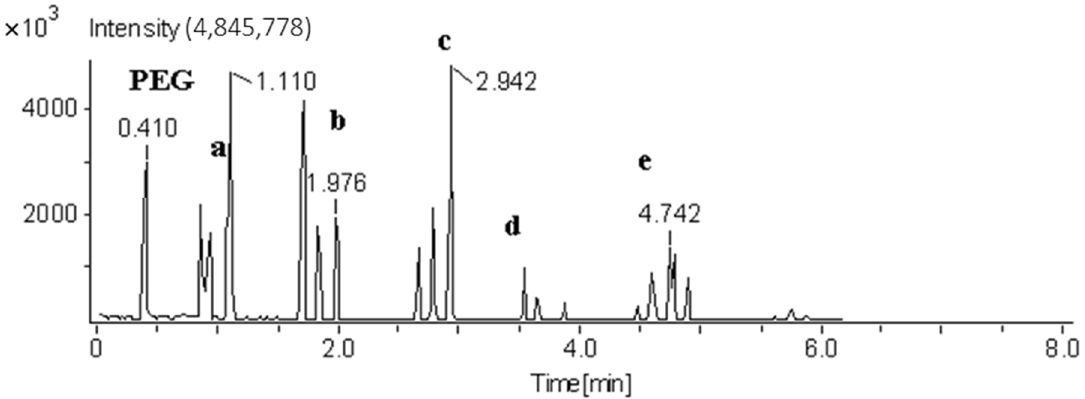
Figure 4. Total ion response of PET at temperatures: ( a ) 300 °C, ( b ) 275 °C, ( c ) 250 °C, ( d ) 225 °C, and ( e ) 200 °C.